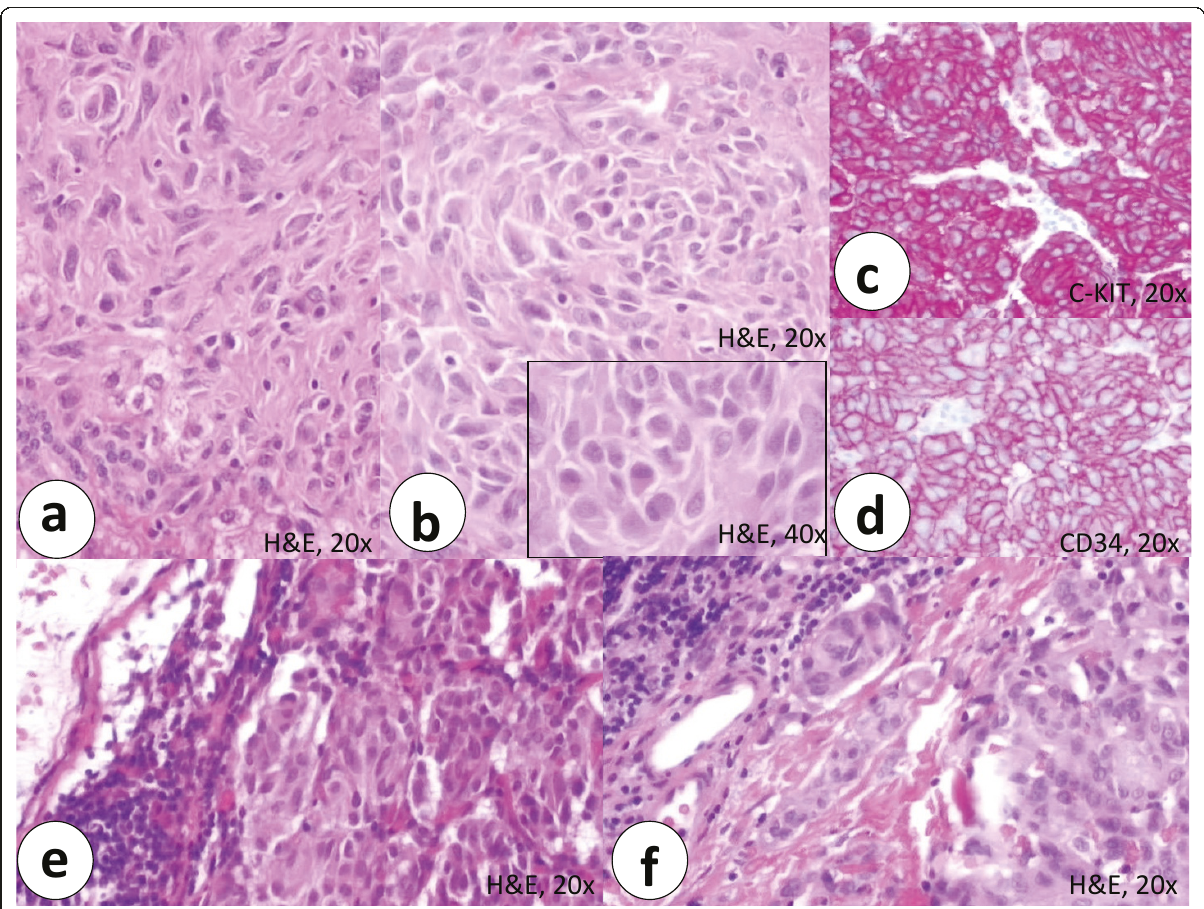
Figure 3 The histomorphological growth pattern of the liver metastasis in case 3 showed a hypercellular tumor (a) with plasmacytoid cells (b and inset) (H&E staining) . Immunohistochemistry of the liver metastasis showed intensive expression of predominantly membranous C-KIT (c) and distinct membranous CD34 (d) staining. The lymph node metastases revealed closely packed hypercellular tumor nodules (e) with lymphangioinvasion (f) (H&E